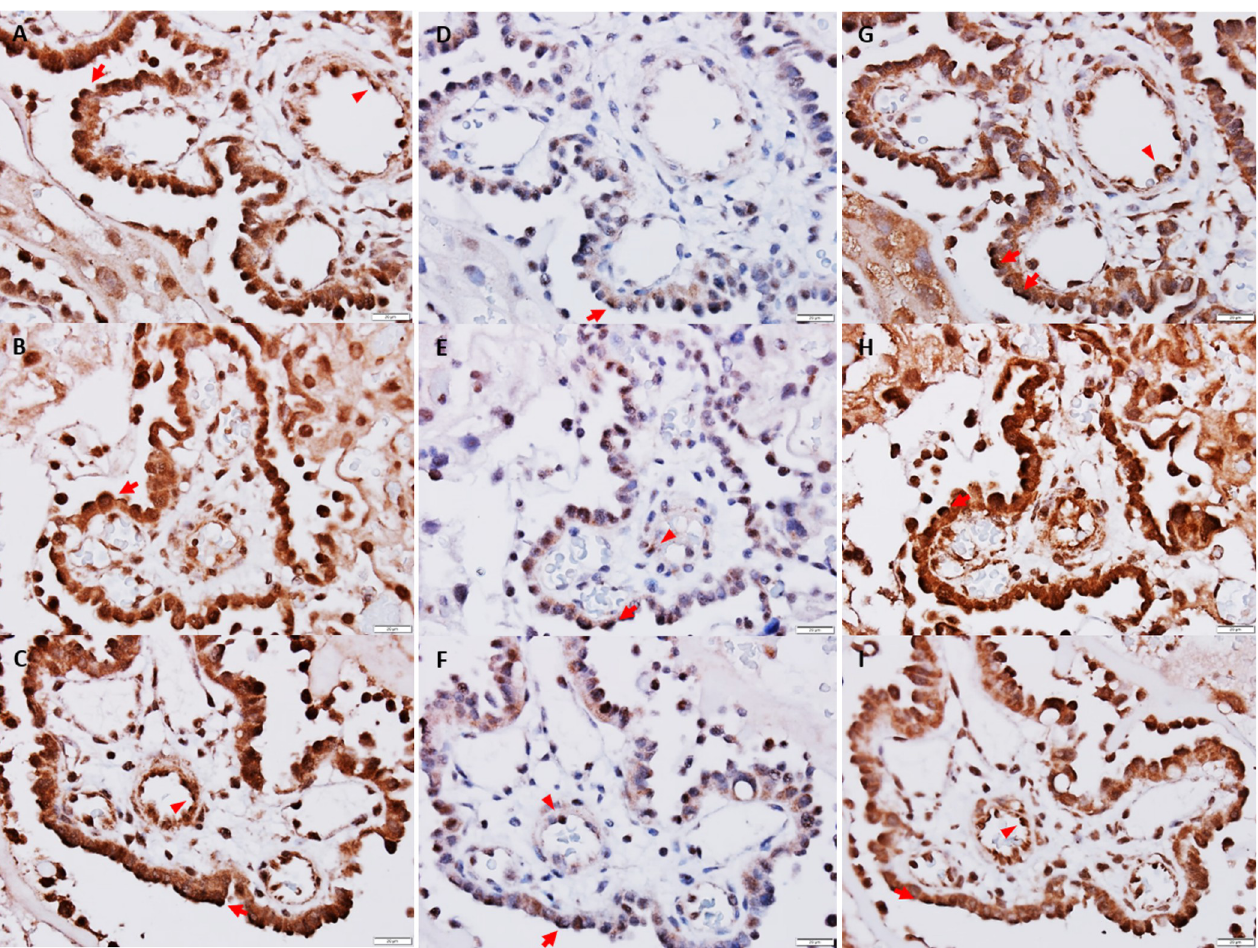
Fig 3. Microscopic images of amino acid transporter and insulin receptor distribution in placenta on GD20. Left panel (A-C): SNAT1 (brown staining). A strong signal is present in the apical plasma membrane of trophoblasts (arrows) and foetal endothelial cells (arrow heads) facing the maternal and foetal circulation, respectively. A diffuse signal is seen in the cytoplasm of both cell types. Middle panel (D-F): SNAT2 (brown staining). A diffuse signal was seen in the cytoplasm of trophoblasts, with an occasional strong signal in the apical plasma membrane (arrows). In foetal endothelial cells, the intracellular signal was very weak or absent; occasionally, a signal was detected in the apical membranes (arrow heads). Right panel (G-I): InsR (brown staining). A strong signal was seen in the apical plasma membranes of both trophoblasts (arrows) and foetal endothelial cells (arrow heads); a diffuse signal was seen in the cytoplasm of both cell types. Overall, signal was strongest in trophoblasts. A, D and G: CTRL group, B, E, and H: HI-GD20 group, C, E, and I: HI-GD17 group. 600 x magnification, scale-bar: 20 μ